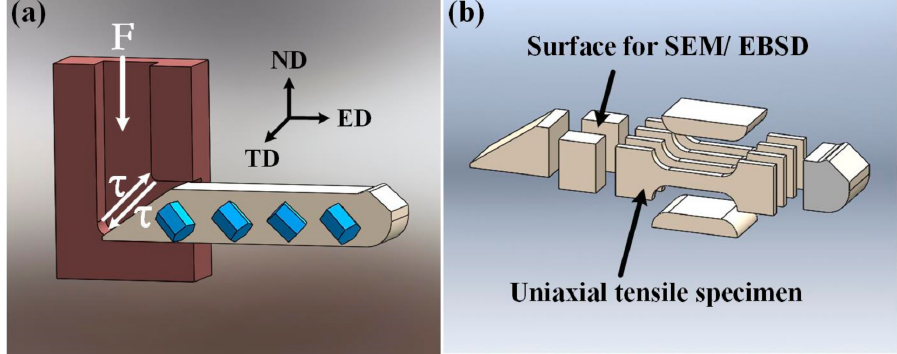
Figure 1. ( a ) Schematic of the ECAP process. ( b ) Samples for microstructure characterization and tensile